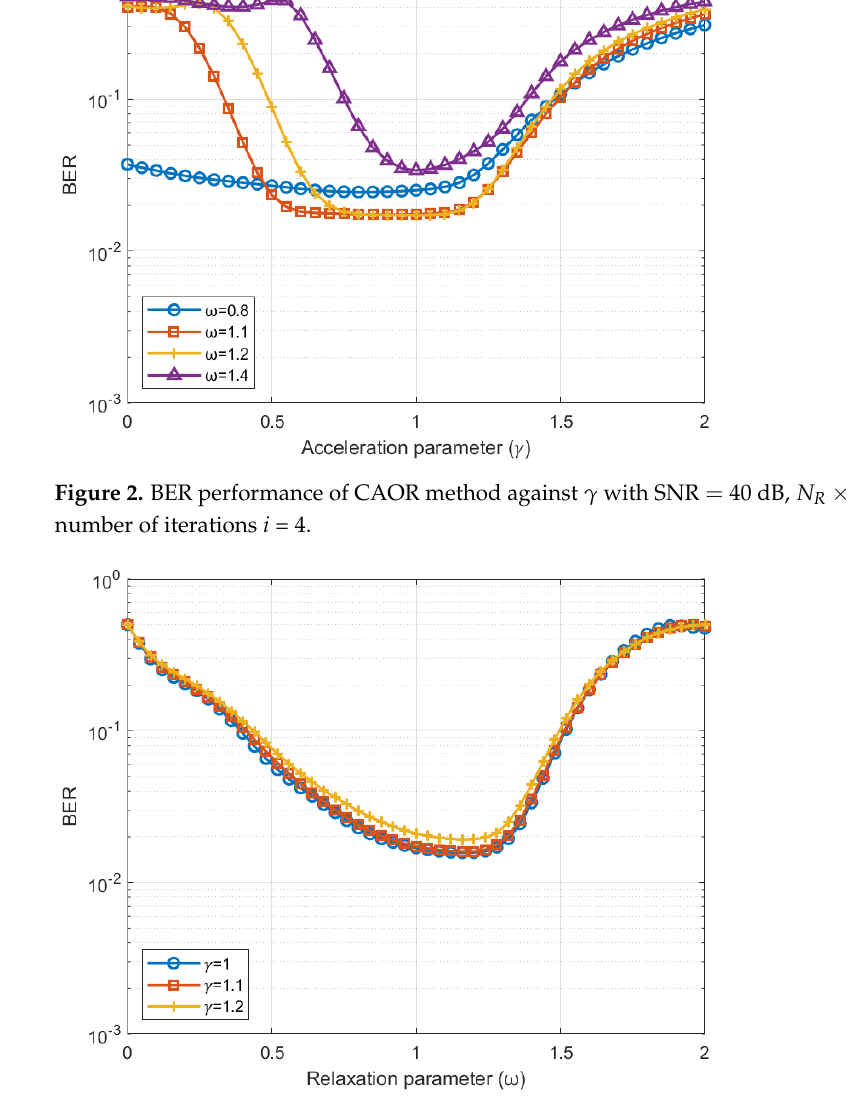
Figure 3. BER performance of CAOR method against ω with SNR = 40 dB, N R × N T = 64 × 16, and number of iterations i =